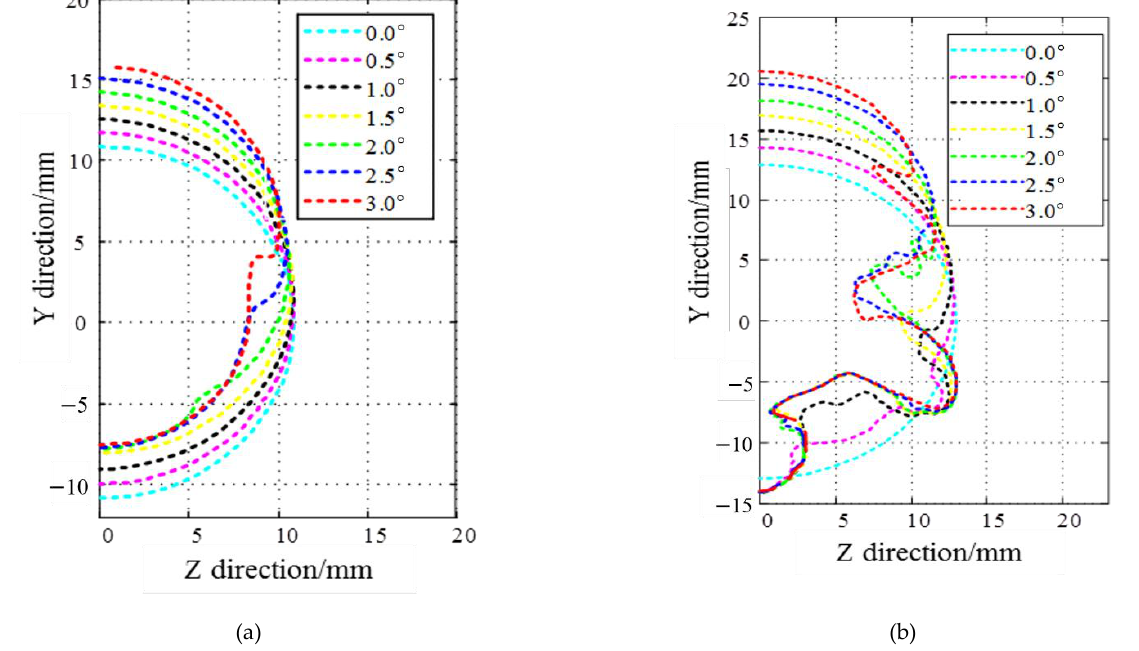
Figure 13. Cavitation cross-sectional shape at different positions of the cavitator with different attack angles. ( a ) Cavitation at 100 mm behind the cavitator; ( b ) cavitation at 160 mm behind the cavitator.